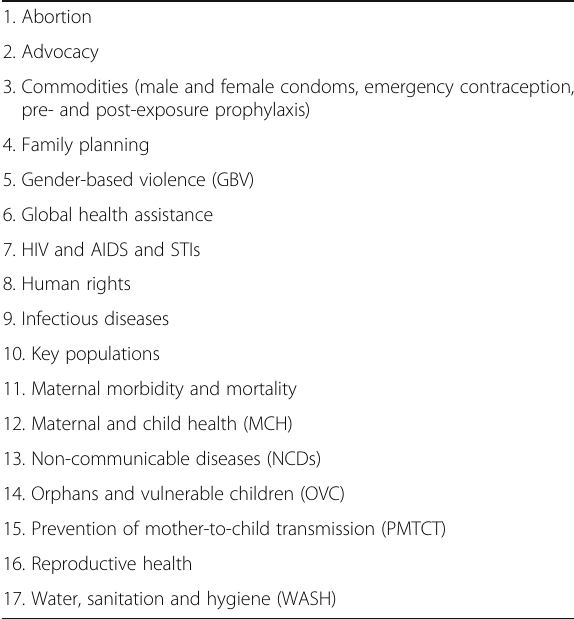
Table 2: Global Health Domains